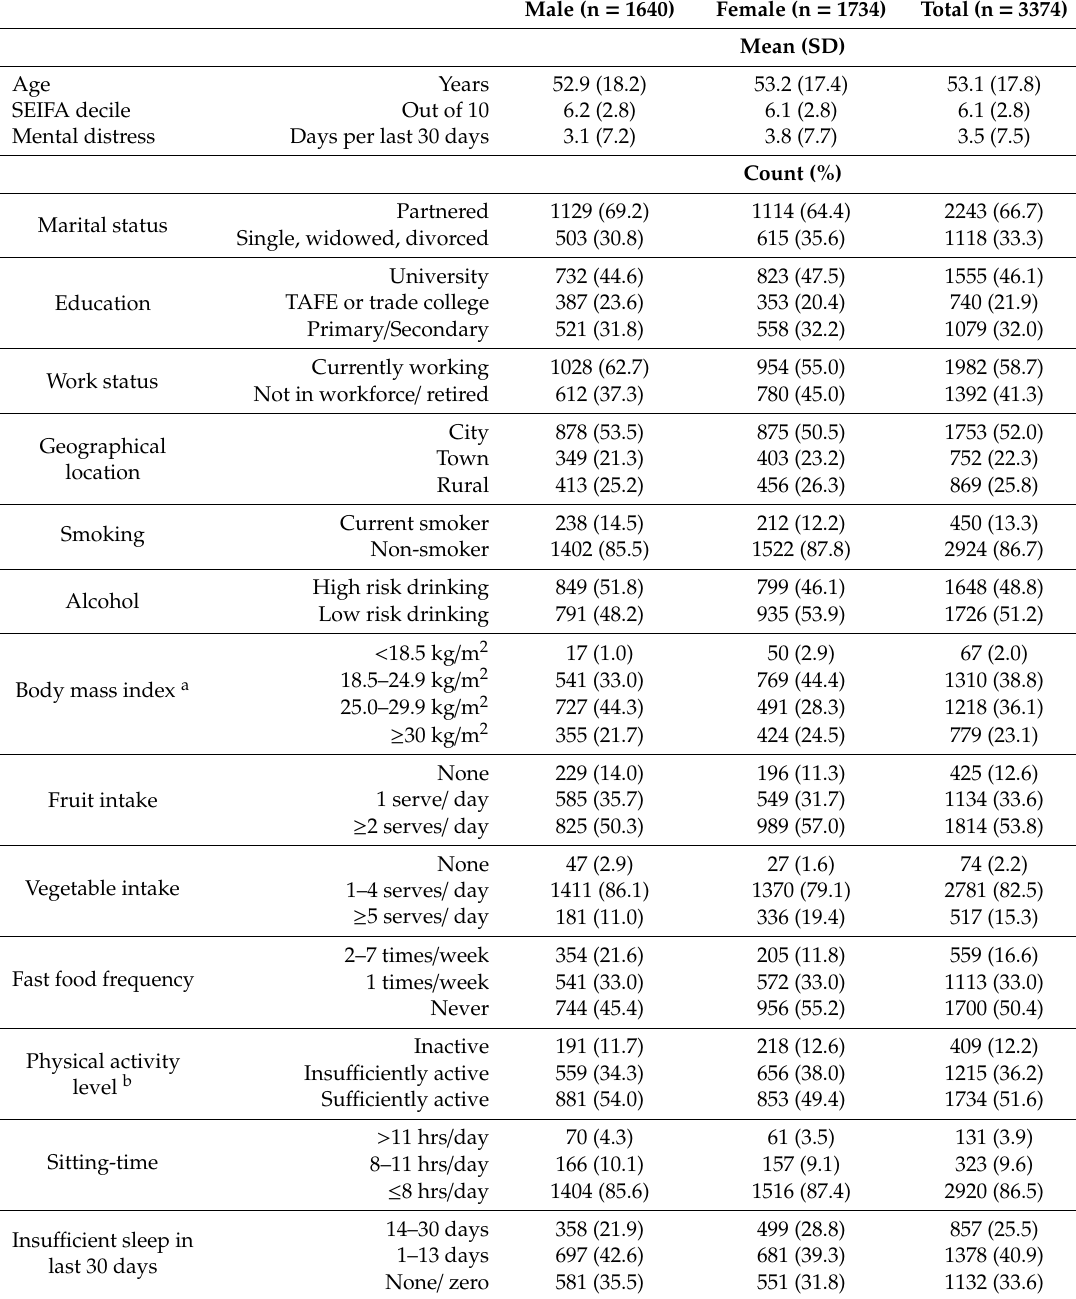
Table 1. Study population characteristics (n =